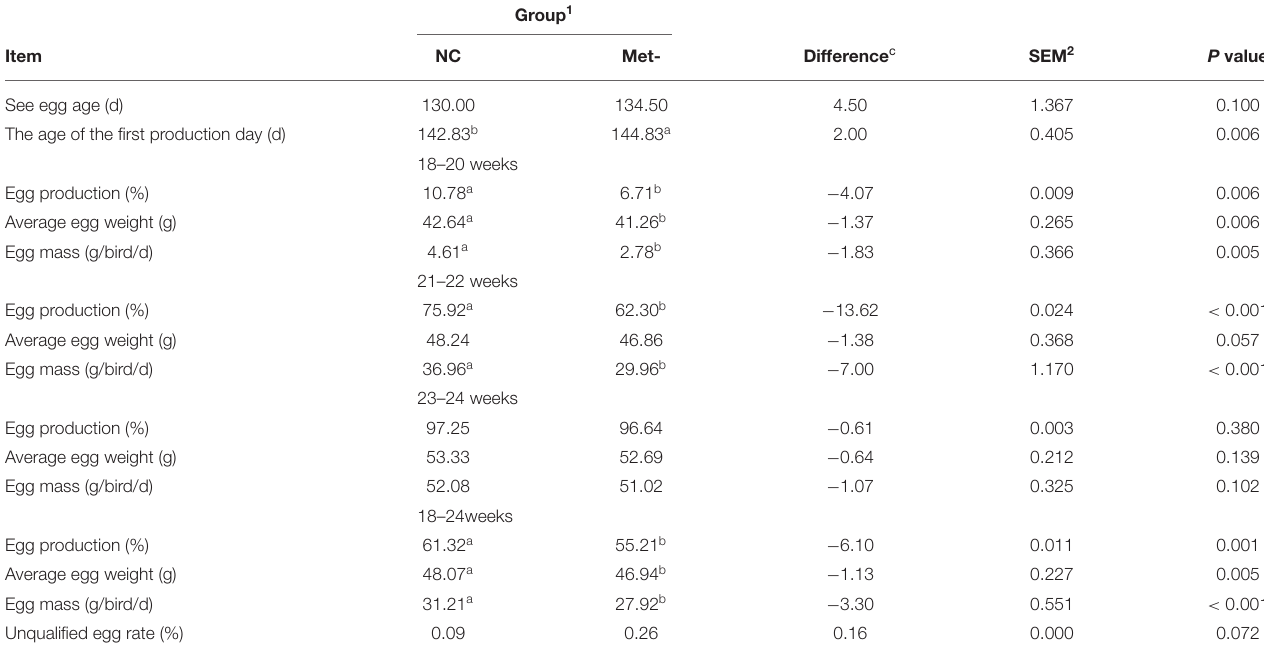
TABLE 4 | Effects of Met deficiency in rearing period diets on Subsequent laying performance of laying